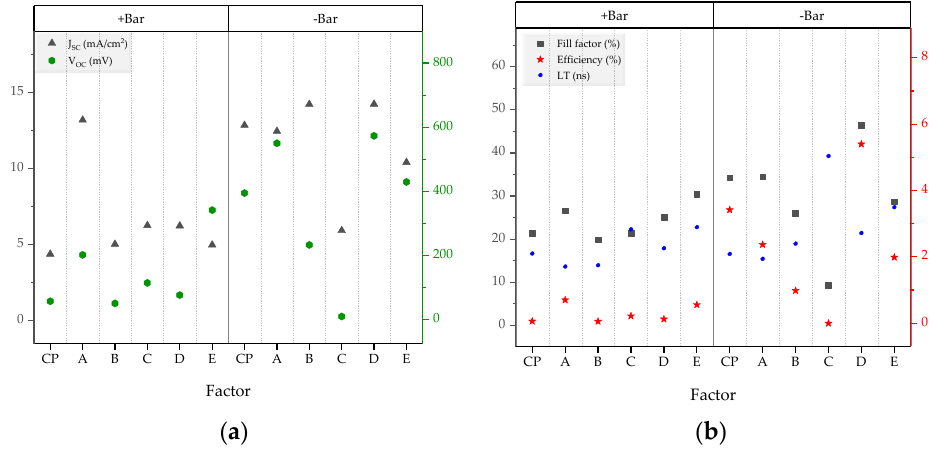
Figure 4. Solar cell device parameters J SC and V OC ( a ) and the Eff, FF and absorber LT ( b ).